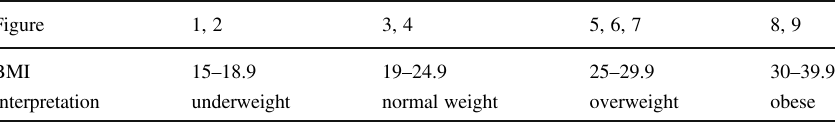
Table 2 Figure Rating Scale: Figure and BMI (Stunkard et al. 1983)